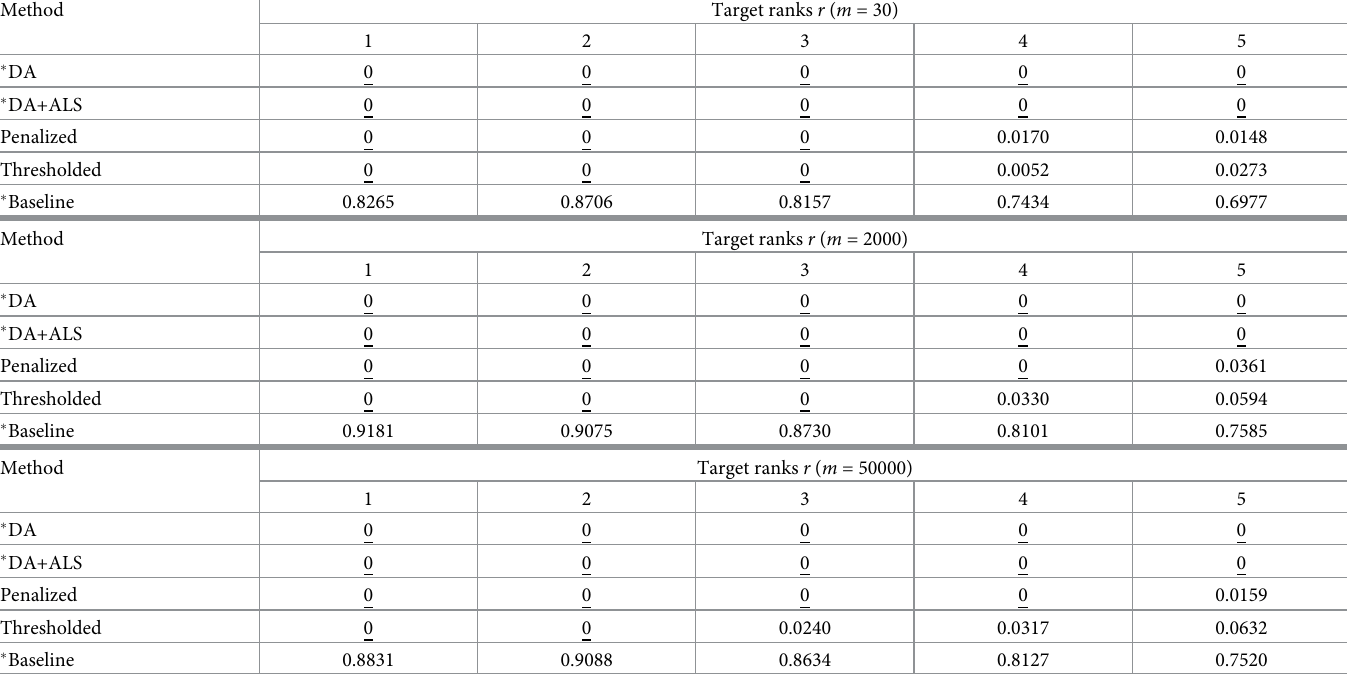
Table 1. Mean relative error for synthetic A with an exact decomposition. The � symbol indicates methods we propose. Best results are underlined.